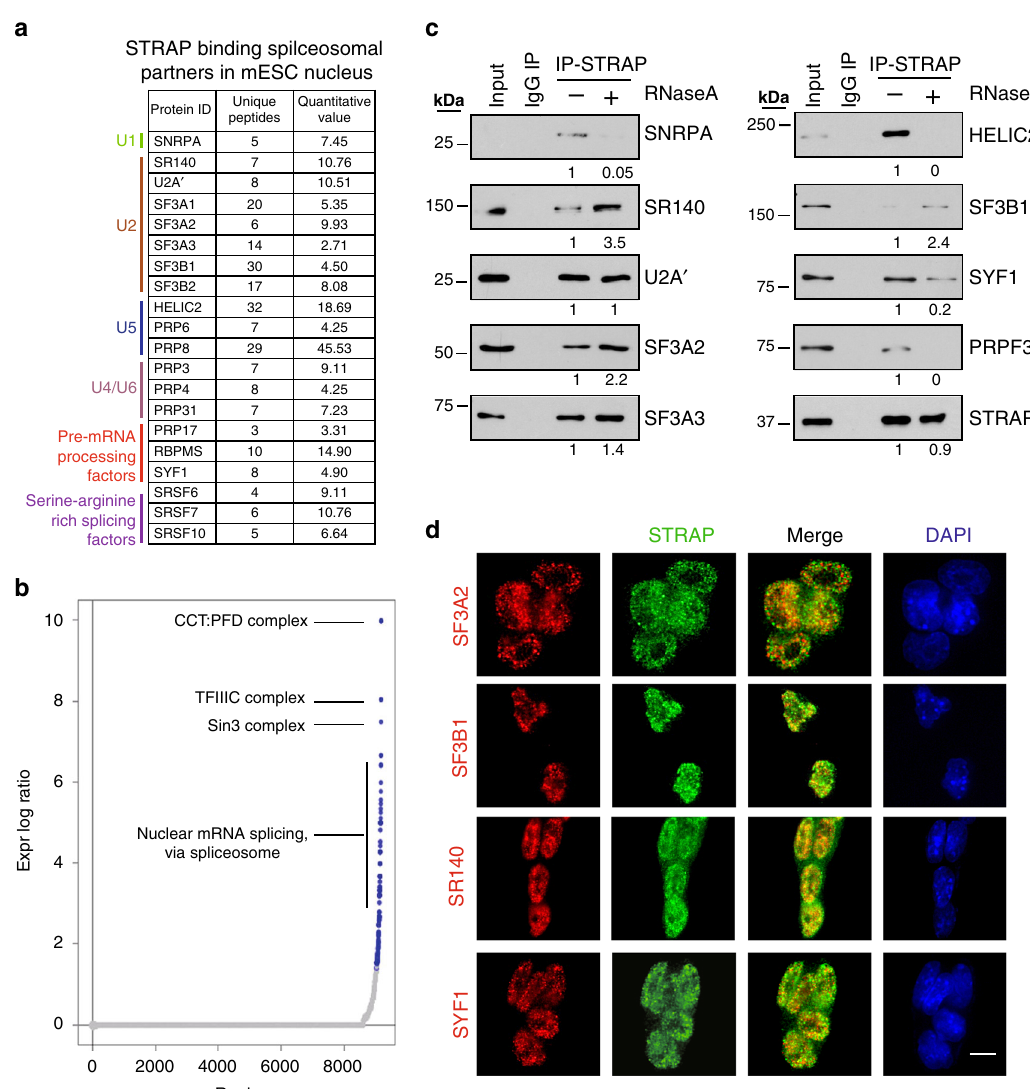
Fig. 3 Intracellular STRAP binds with subunits of the spliceosome complex. a List of STRAP-binding proteins for spliceosome complex subunits. Anti- STRAP antibody was used to immunoprecipitate STRAP and co-precipitate its interacting proteins from mouse ESC nuclear extracts (NE). The binding partners were identi fi ed by LC-MS/MS. b Ranked curve for STRAP binding-partners (see method). Enriched complexes (colored dots) are those that meet the P -value cutoff ( P < 5.012e − 2). Top enriched complexes are indicated. c Interactions between indicated proteins and STRAP were con fi rmed by co- immunoprecipitation and Western blotting analyses. Samples were prepared as in ( a ) and treated with or without ribouclease A (RNase A). 1% of lysates were loaded as input control. The levels of co-precipitated proteins after RNase treatment (relative to untreated control) are shown below the gel pictures. The experiment was independently repeated twice with similar results. d The localization of STRAP (green) and indicated proteins (red) in mouse ESC cells were analyzed by immuno fl uorescence. Cell nuclei were labeled by DAPI (blue) staining. Scale bar, 10 µ m. Images were captured by a Keyence microscope. The experiment was repeated three times independently with similar